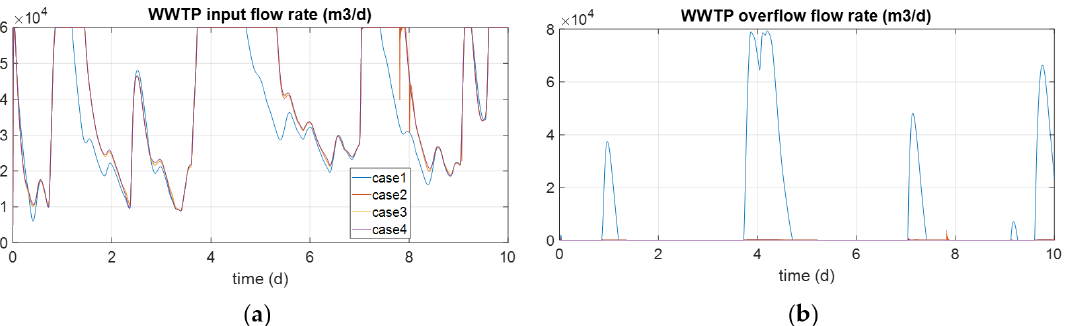
Figure 15. WWTP input ( a ) and overflow flow rates ( b